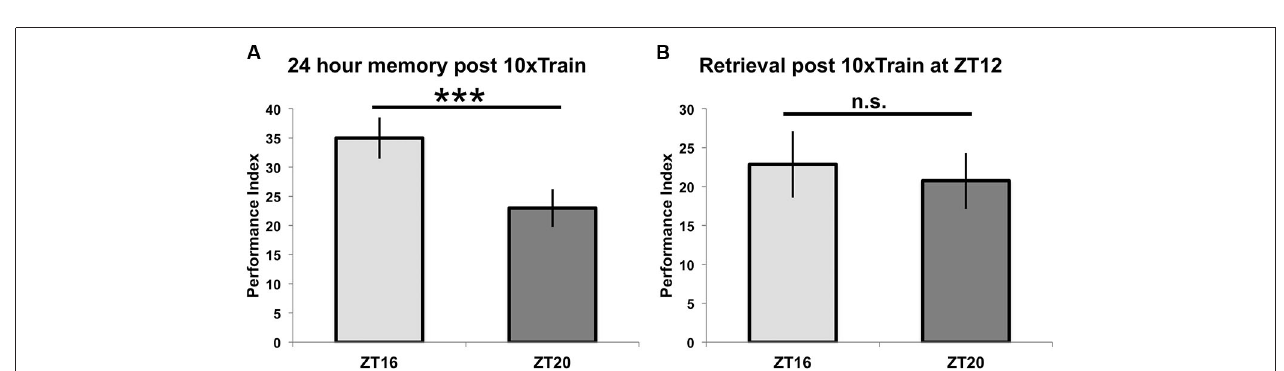
FIGURE 3 | Time of training does not affect learning or immediate memory. Wild-type flies entrained to a 12-12 light-dark schedule were trained at either ZT16 or ZT20 with (A) a single trial of paired olfactory conditioning or (B) 10x spaced olfactory conditioning ( n = 8 for all groups). Animals were tested immediately after training, and performance is